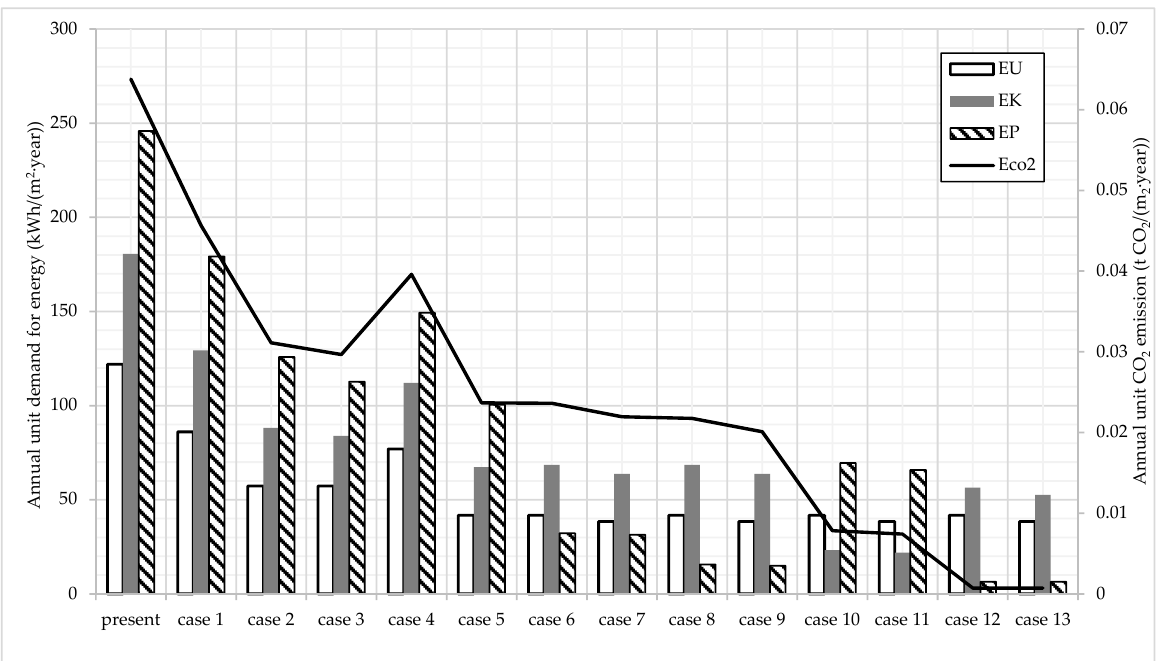
Figure 14. Impact of thermomodernization measures on the annual units demand for: usable (EU), final (EK), and primary energy (EP), as well as emission of CO 2 for the analyzed lecture room.